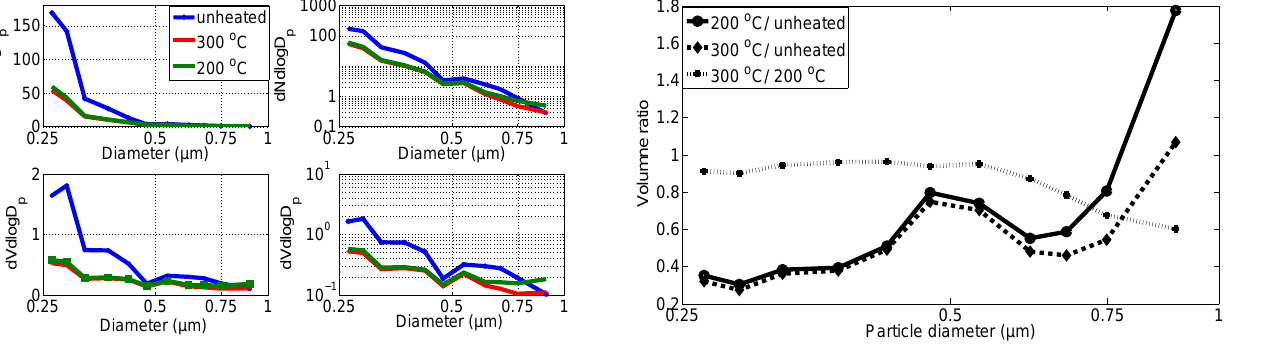
Fig. 5. Volume ratio distribution for different temperature incre-